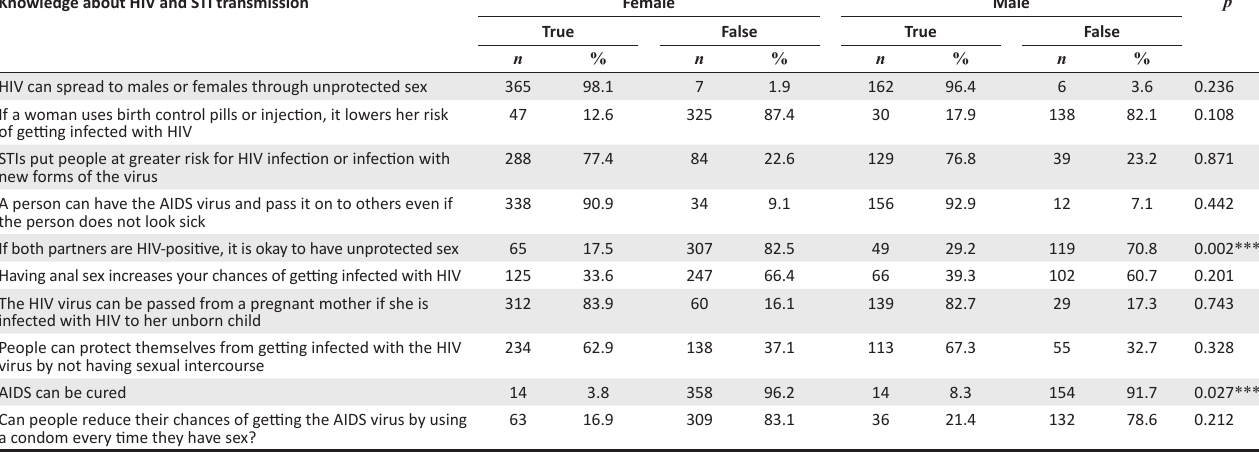
TABLE 3b: Frequency and percentage of students’ knowledge and awareness of HIV and AIDS. Knowledge about HIV and STI transmission